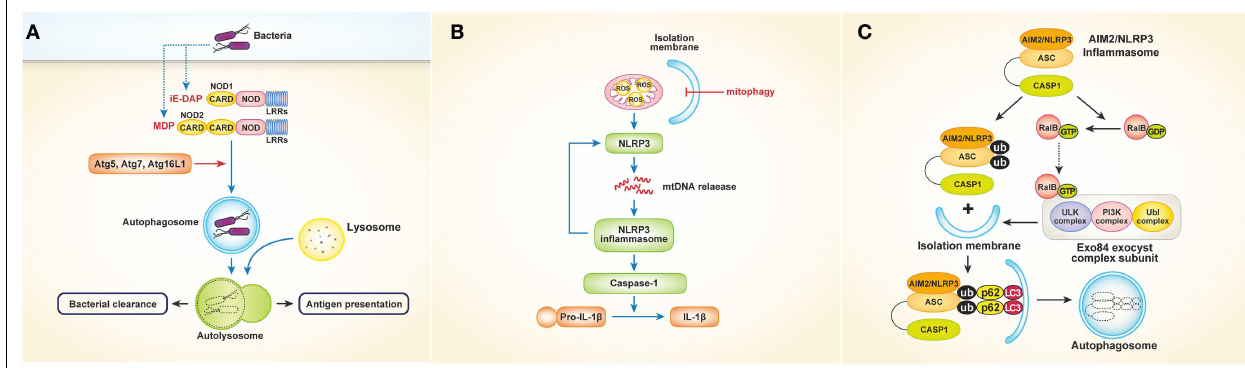
FIGURE 2 | Interactions between NLRs or inflammasomes and autophagy. (A) Activation of NOD1 and NOD2 by bacteria induces autophagosome formation, which leads to facilitating bacterial clearance and MHC class II-associated antigen presentation. In this process, autophagy proteins such as Atg5, Atg7, and Atg16L1 are required. (B) Autophagy (especially mitophagy) regulates NLRP3 inflammasomes- induced inflammatory responses by quality control of mitochondrial integrity. Blocking mitophagy leads to the accumulation of damaged, ROS-generating mitochondria, which in turn activates NLRP3 inflammasomes.The NLRP3 inflammasome also contributes to